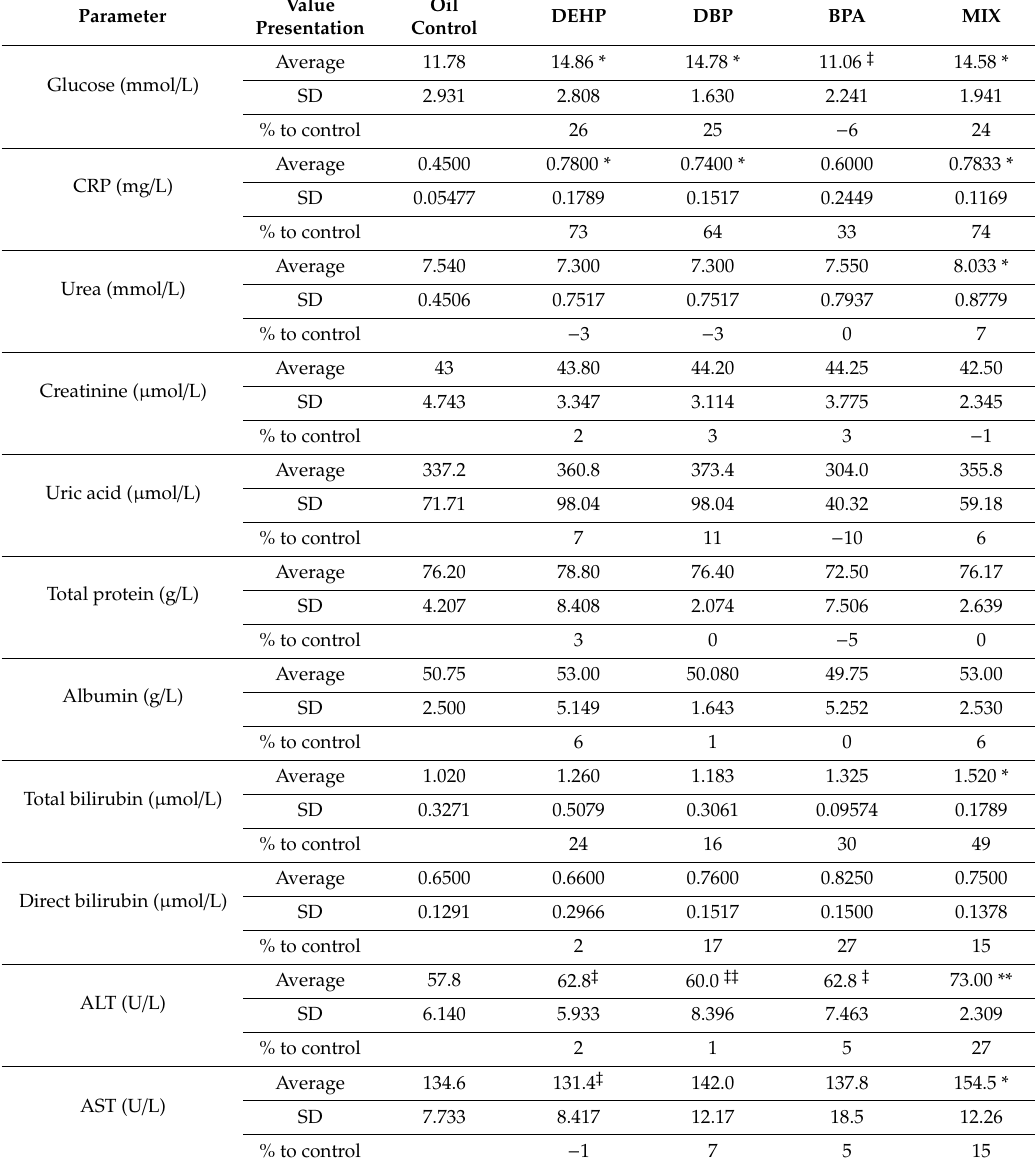
Table 6. Biochemical parameters for male rats after 28 days of oral exposure to single investigated substances (DEHP, DBP, and BPA) and their mixture